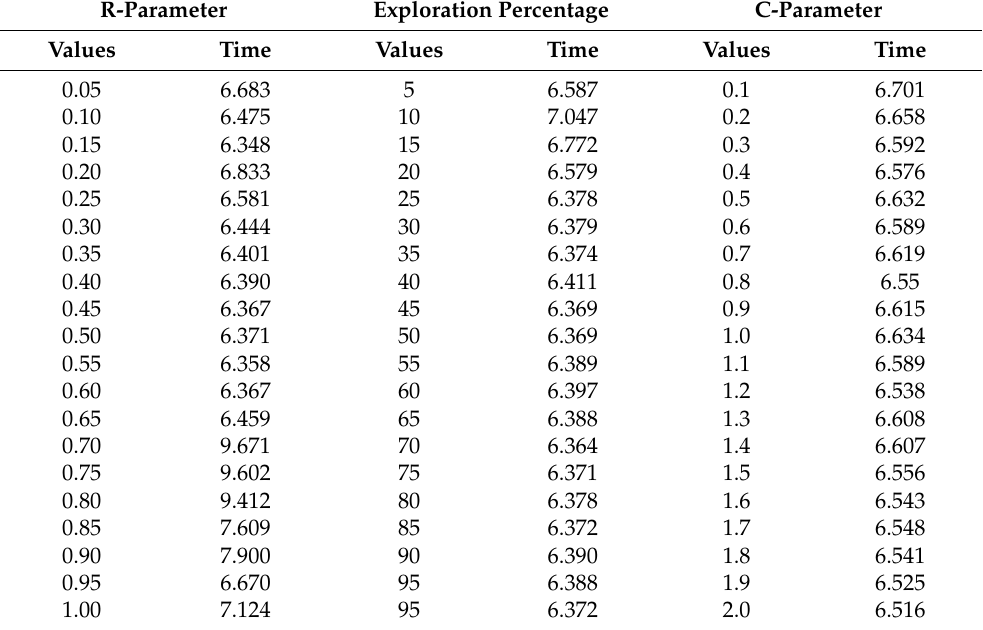
Table 8. Results of convergence time (in seconds) for different values of DTO’s parameters.